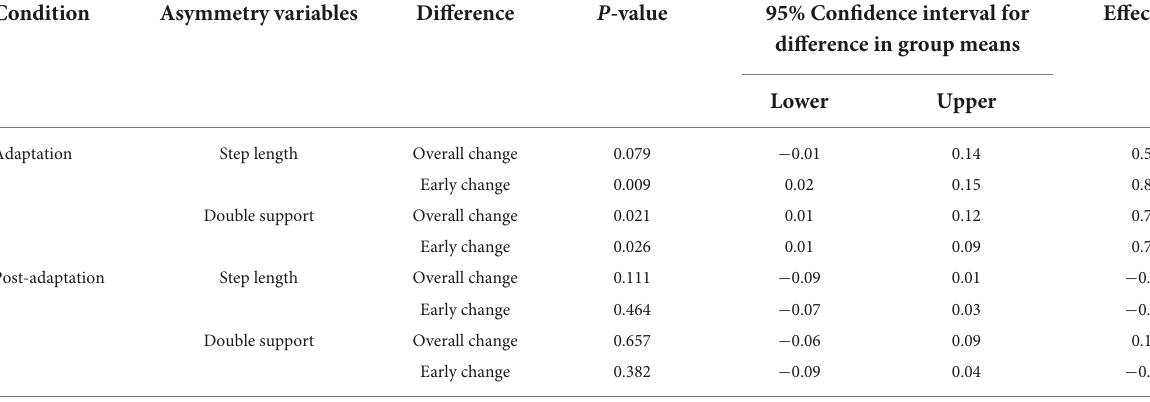
TABLE 3 Age group differences in kinematic asymmetry during adaptation and